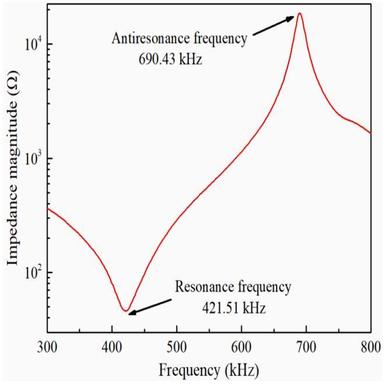
Low-field impedance spectrum of the PMN-PT single crystal/ epoxy 1–3 composite disk under thickness vibration mode.